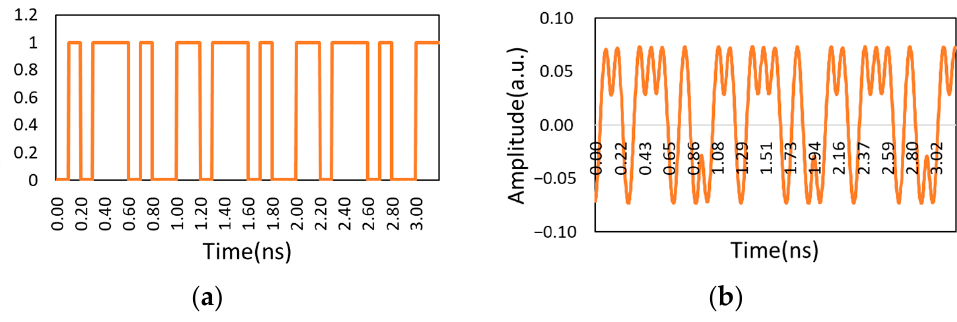
Figure 10. Waveform without phase difference: ( a ) Modulation waveform of CSRZ-DPSK; ( b ) Demodulation waveform without phase difference.